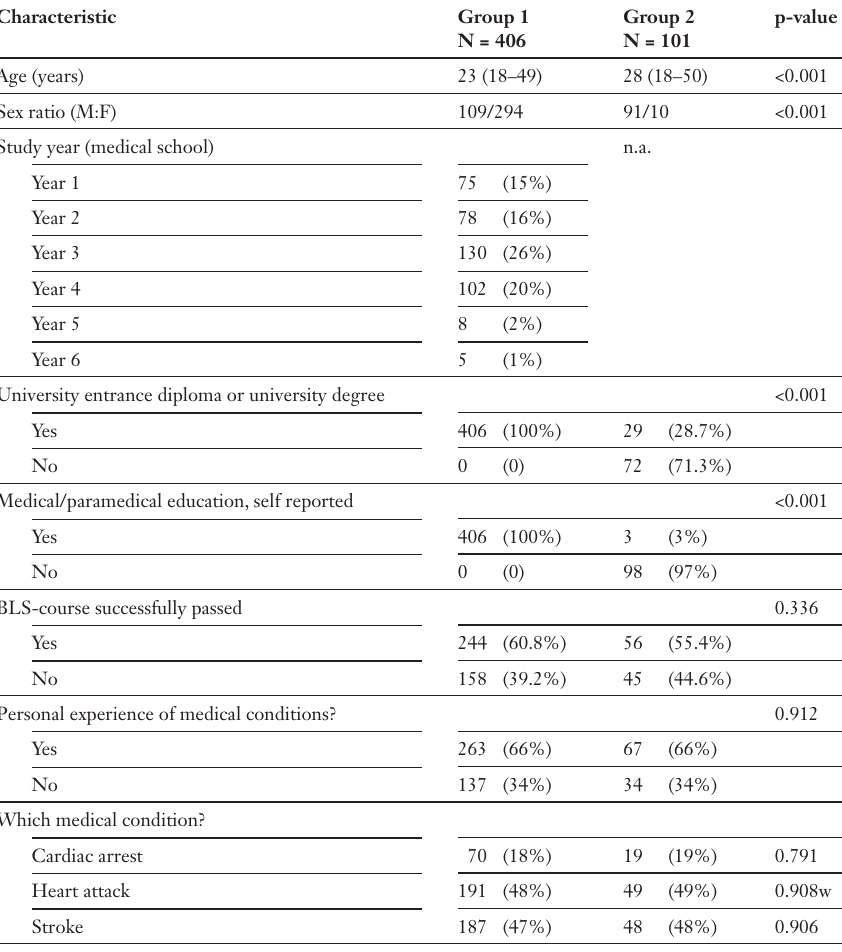
Table 1 Demographics of 507 participants.